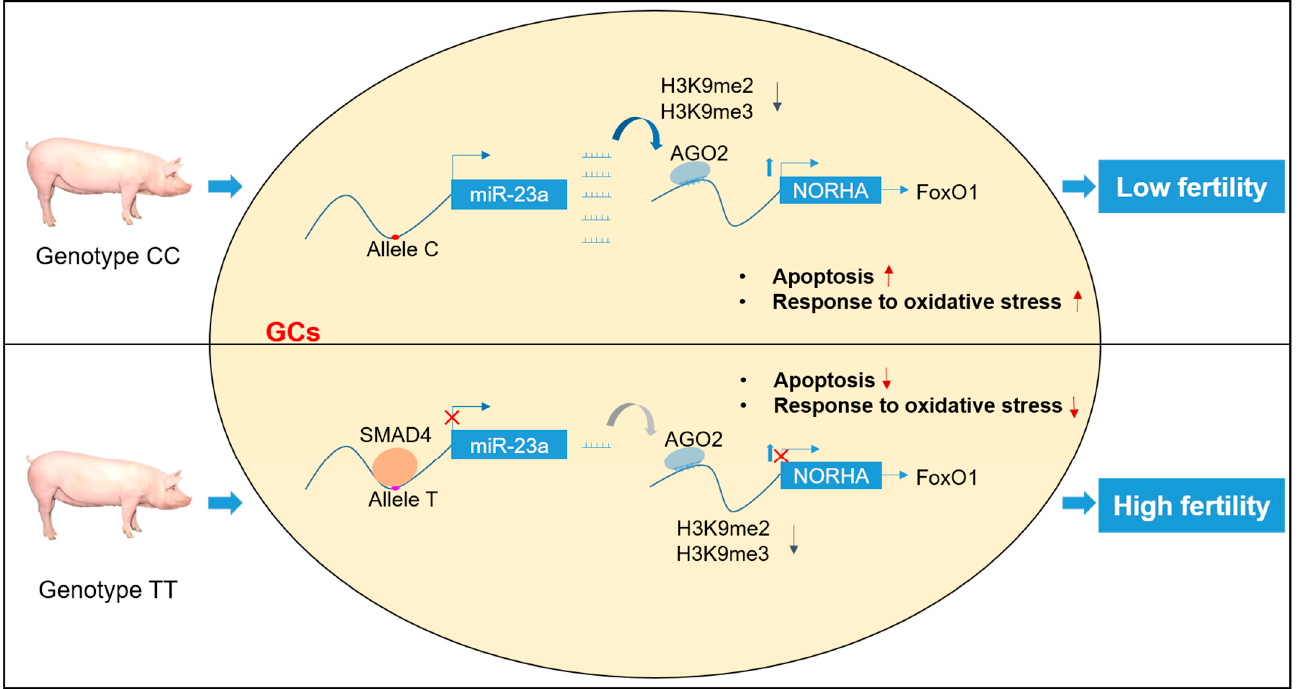
Figure 8. Working model. The SNV g. − 398C>T for sow fertility traits in the miR-23a promoter mediated the regulation of NORHA expression by affecting miR-23a expression, which in turn affected pGCs apoptosis and the pGCs response to oxidative stress.